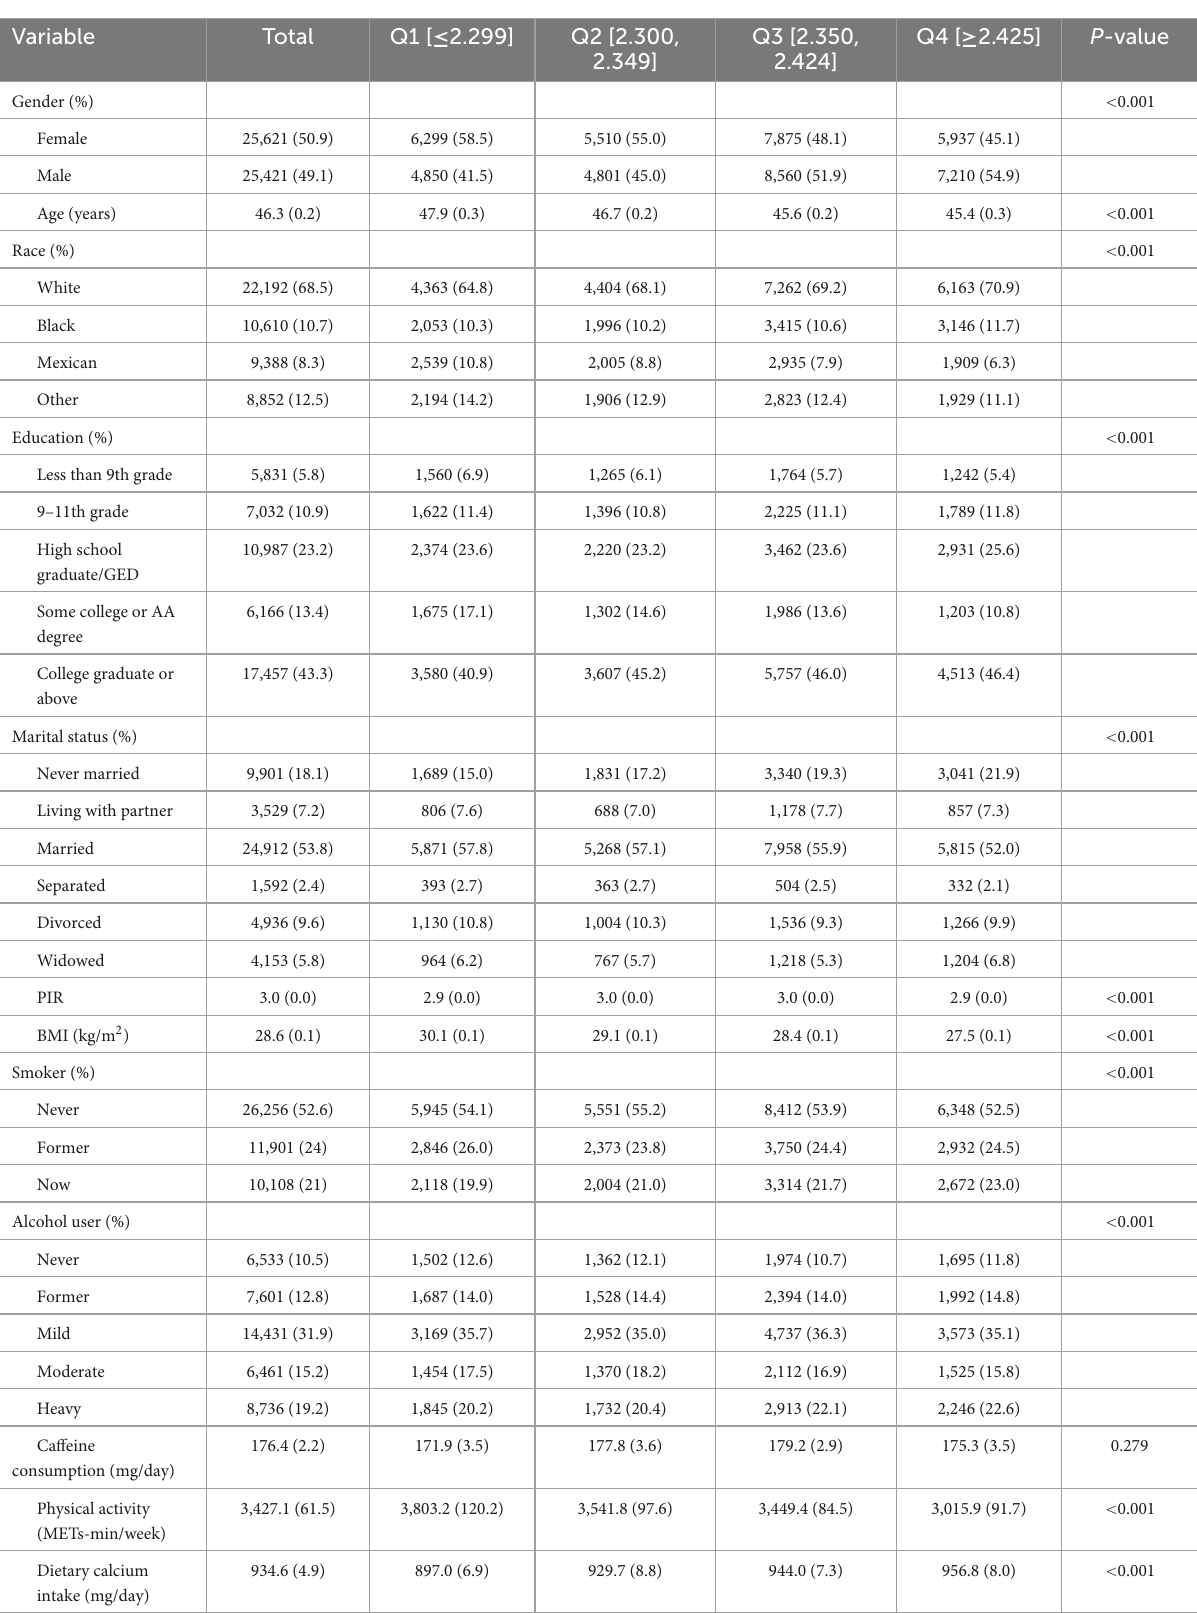
TABLE 1 Baseline characteristics of participants in different quartiles of serum calcium.